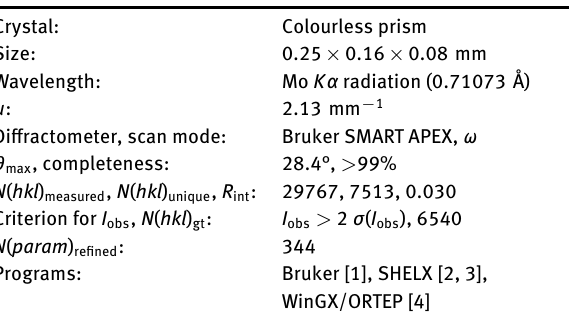
Table 1: Data collection and